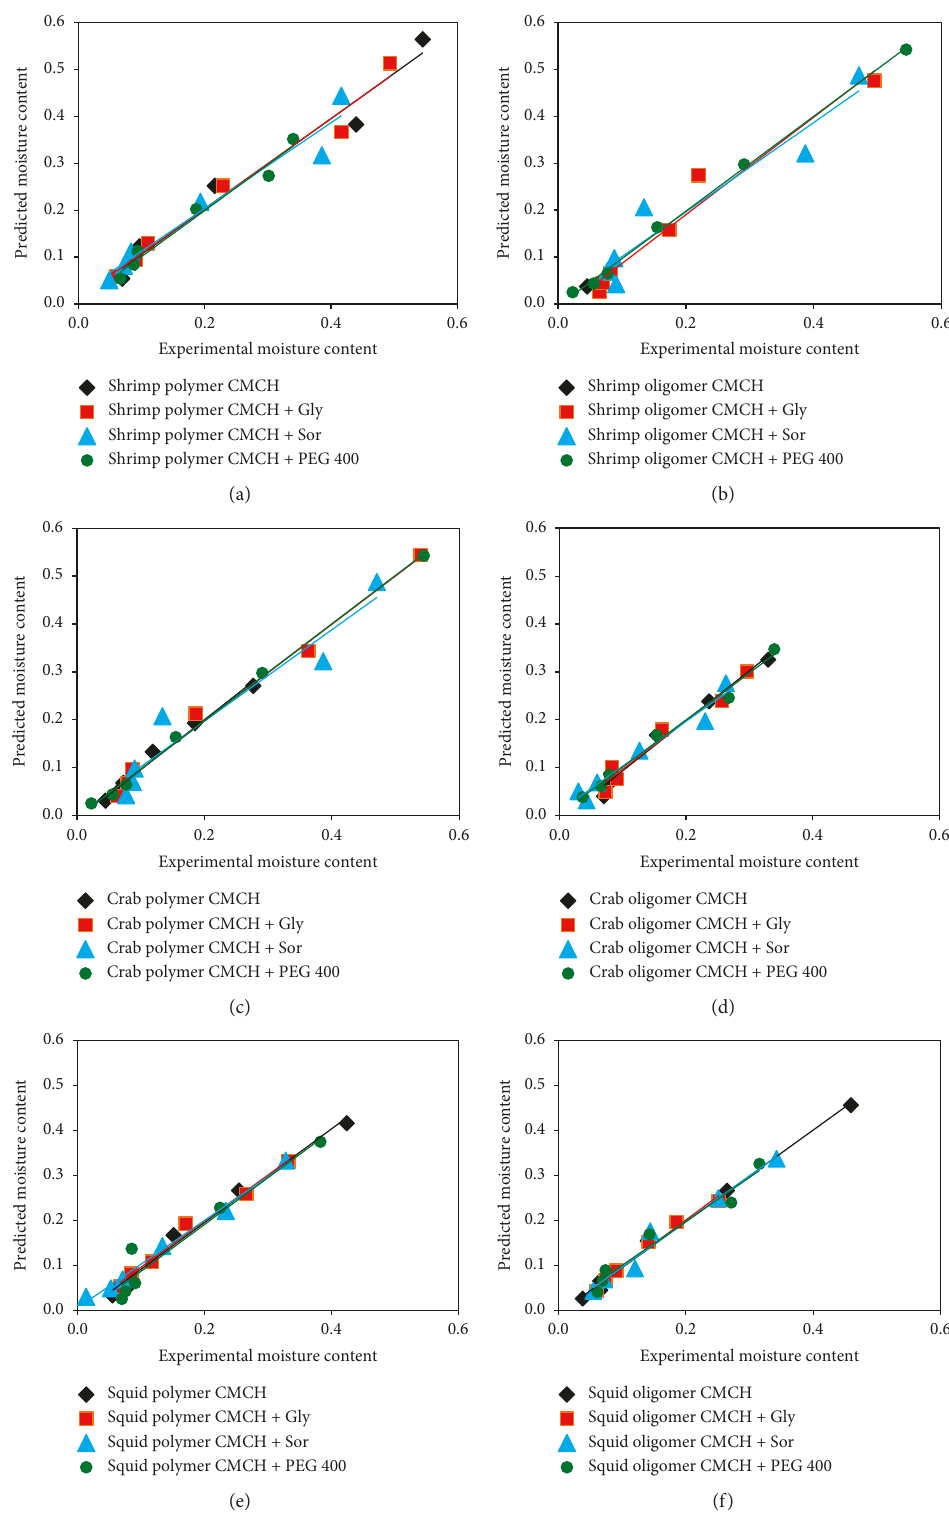
Figure 11: The comparison between the experimental moisture content values and those predicted for all the CMCH films from the Lewicki-3 model: shrimp polymer CMCH films (a); shrimp oligomer CMCH films (b); crab polymer CMCH films (c); crab oligomer CMCH films (d); squid polymer CMCH films (e); squid oligomer CMCH films